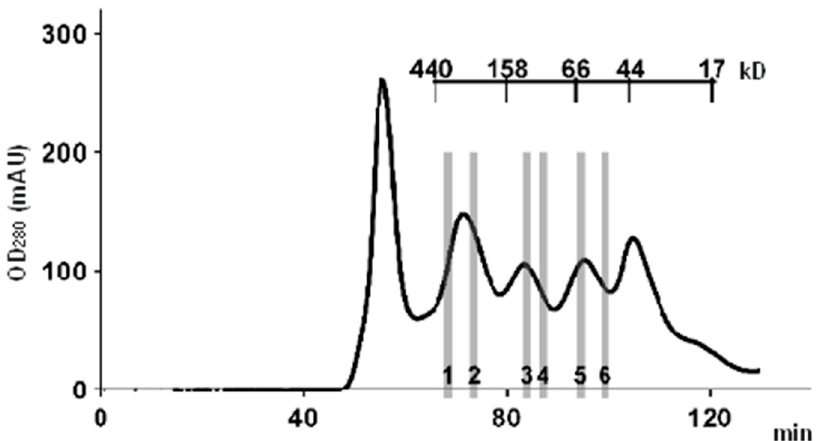
Figure 2. A typical chromatogram of a high-performance SEC fractionation of whole liver tissue lysate. AKTA Purifier 10 chromatograph (GE Healthcare) and HiLoad 16/600 high resolution column (GE Healthcare), filled with Superdex 200 and equilibrated with HBS-EP buffer (10 mM HEPES (pH 7.4), 150 mM NaCl, 3 mM EDTA, and 0.05% Tween-20), were used for protein separation. Six lysate fractions, which were selected for comparative analysis of the protein composition, are indicated by numbers 1–6. The figure was adapted with permission from Ref. [36]; “Pleiades Publishing, Ltd.”, 2018.